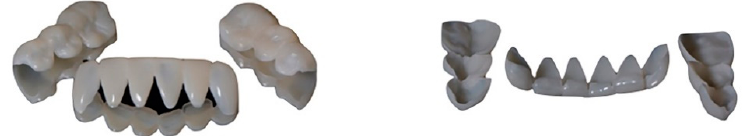
Appl. Sci. 2020 , 10 , x FOR PEER REVIEW Figure 2. Occlusal, labial / facial and lingual views of the mockup obtained with a digital technique. Figure 2. Occlusal, labial/facial and lingual views of the mockup obtained with a digital technique.